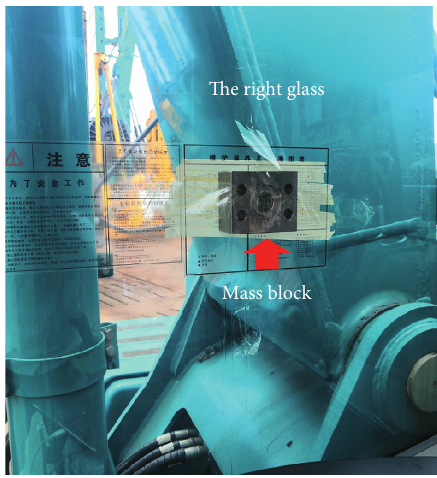
Figure 21: Manual verification on the right glass.